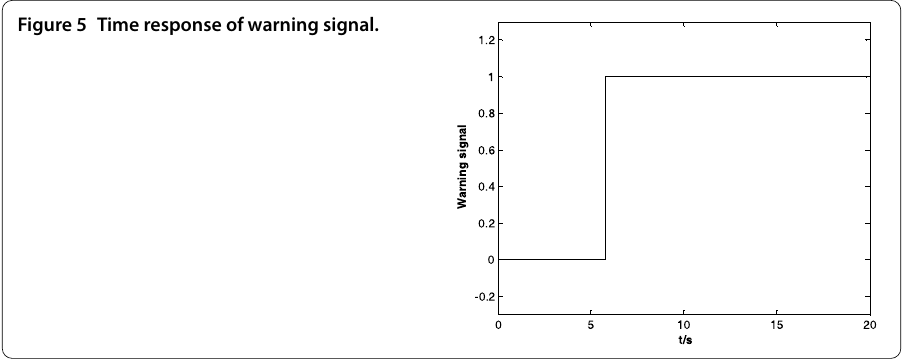
Figure 5 Time response of warning